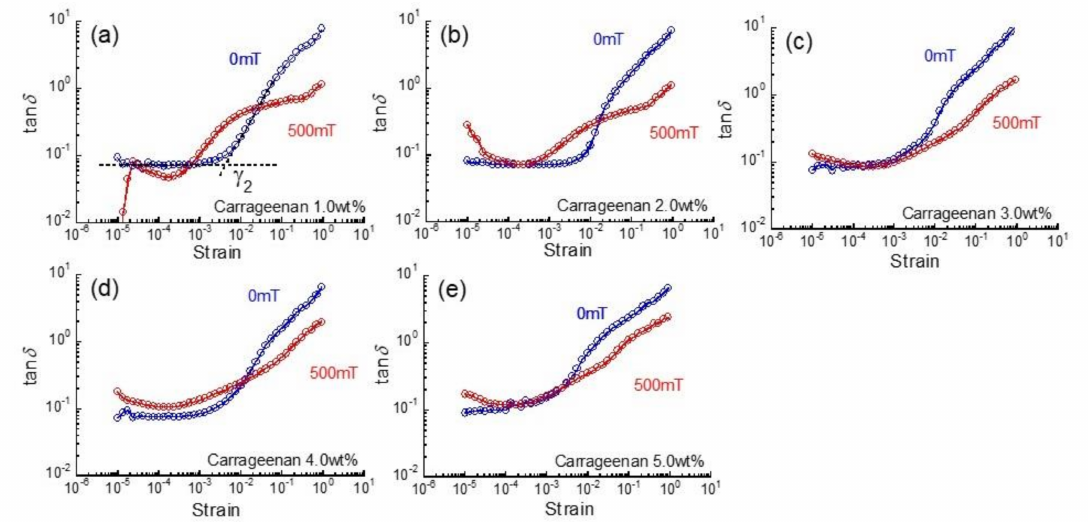
Figure 3. Relationship between characteristic strain ( a ) γ 1 or ( b ) γ 2 and carrageenan concentration for magnetic hydrogels (CI: 70 wt%) and carrageenan hydrogels without magnetic particles.